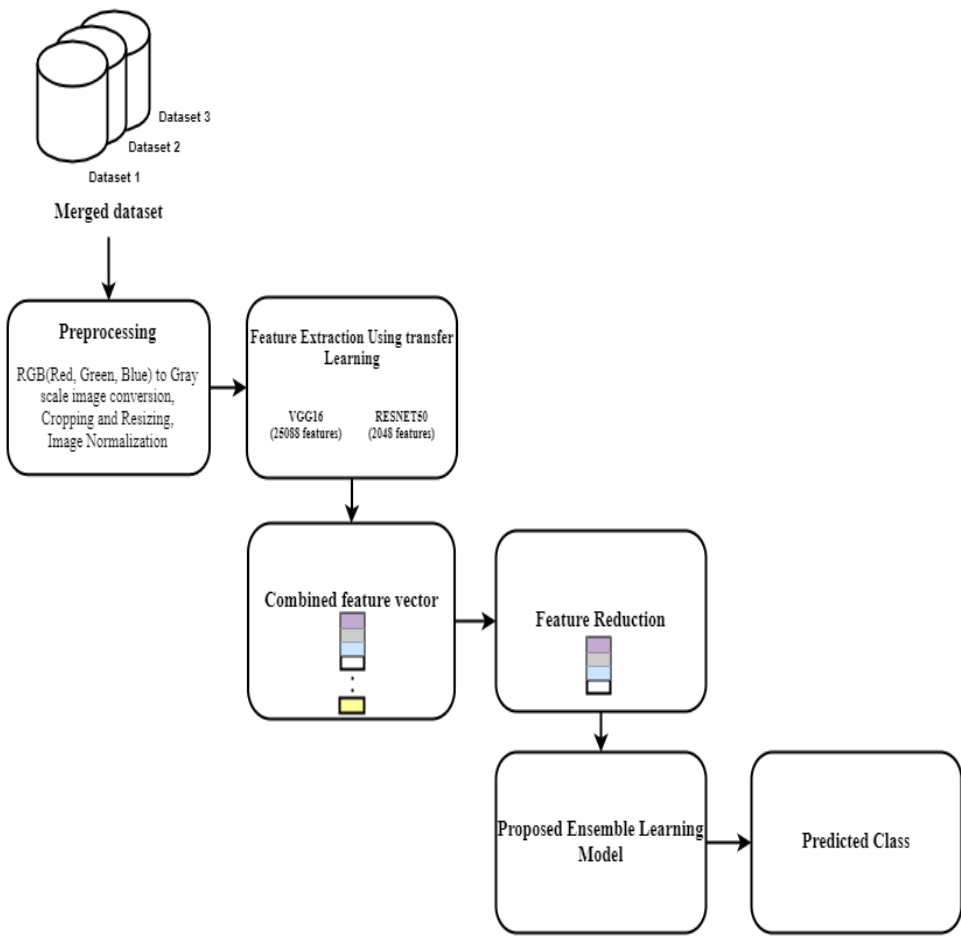
Figure 1. Overall framework of the proposed model.